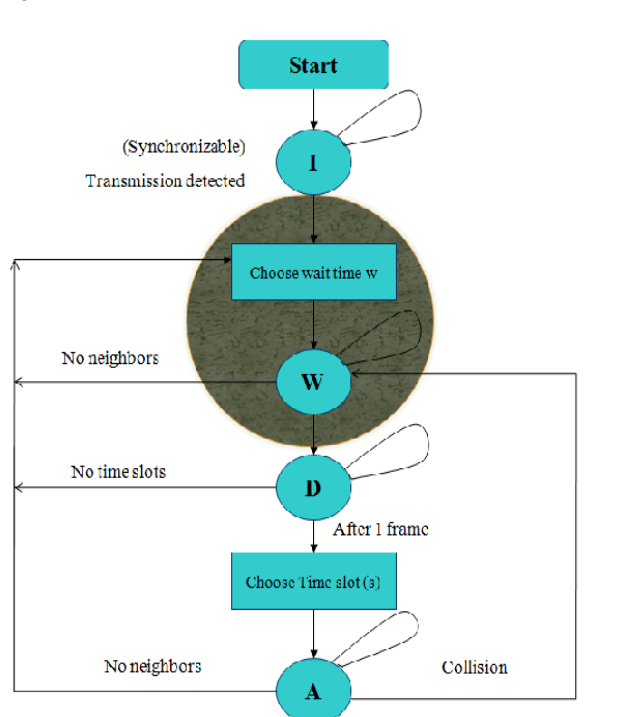
Figure 3. Control flow diagram of LMAC